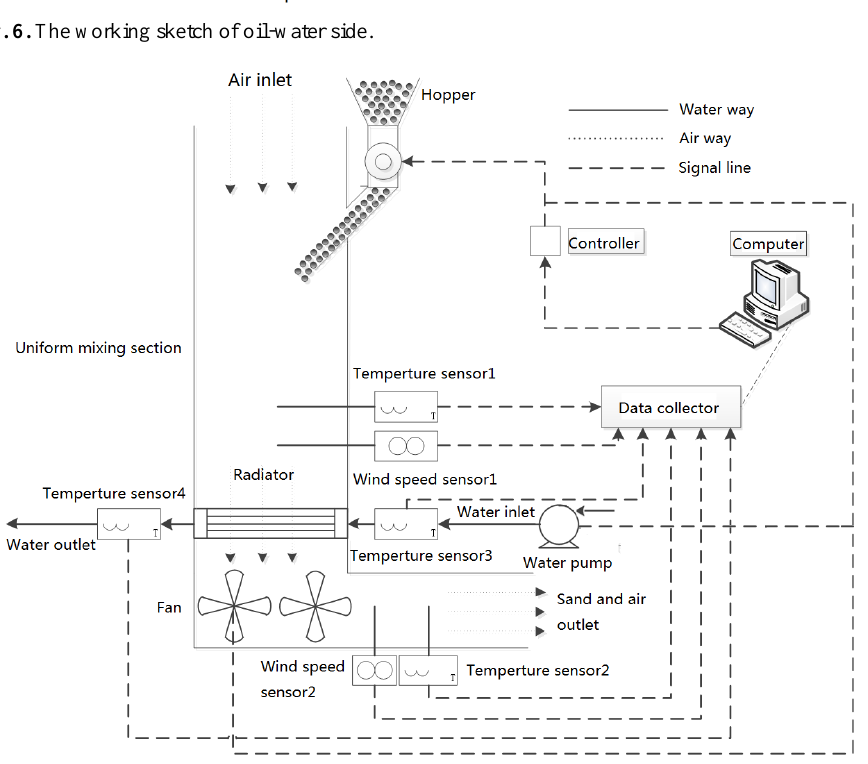
Fig. 7. The working sketch of air